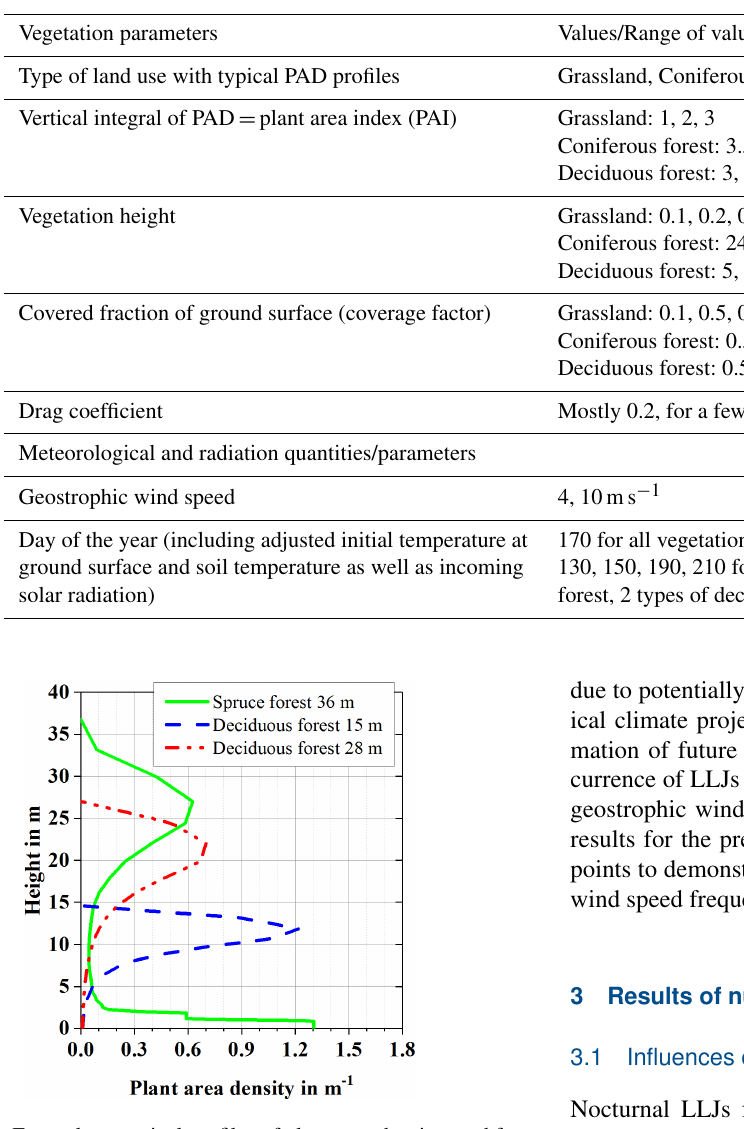
Figure 1. Exemplary vertical profiles of plant area density used for model simulations with